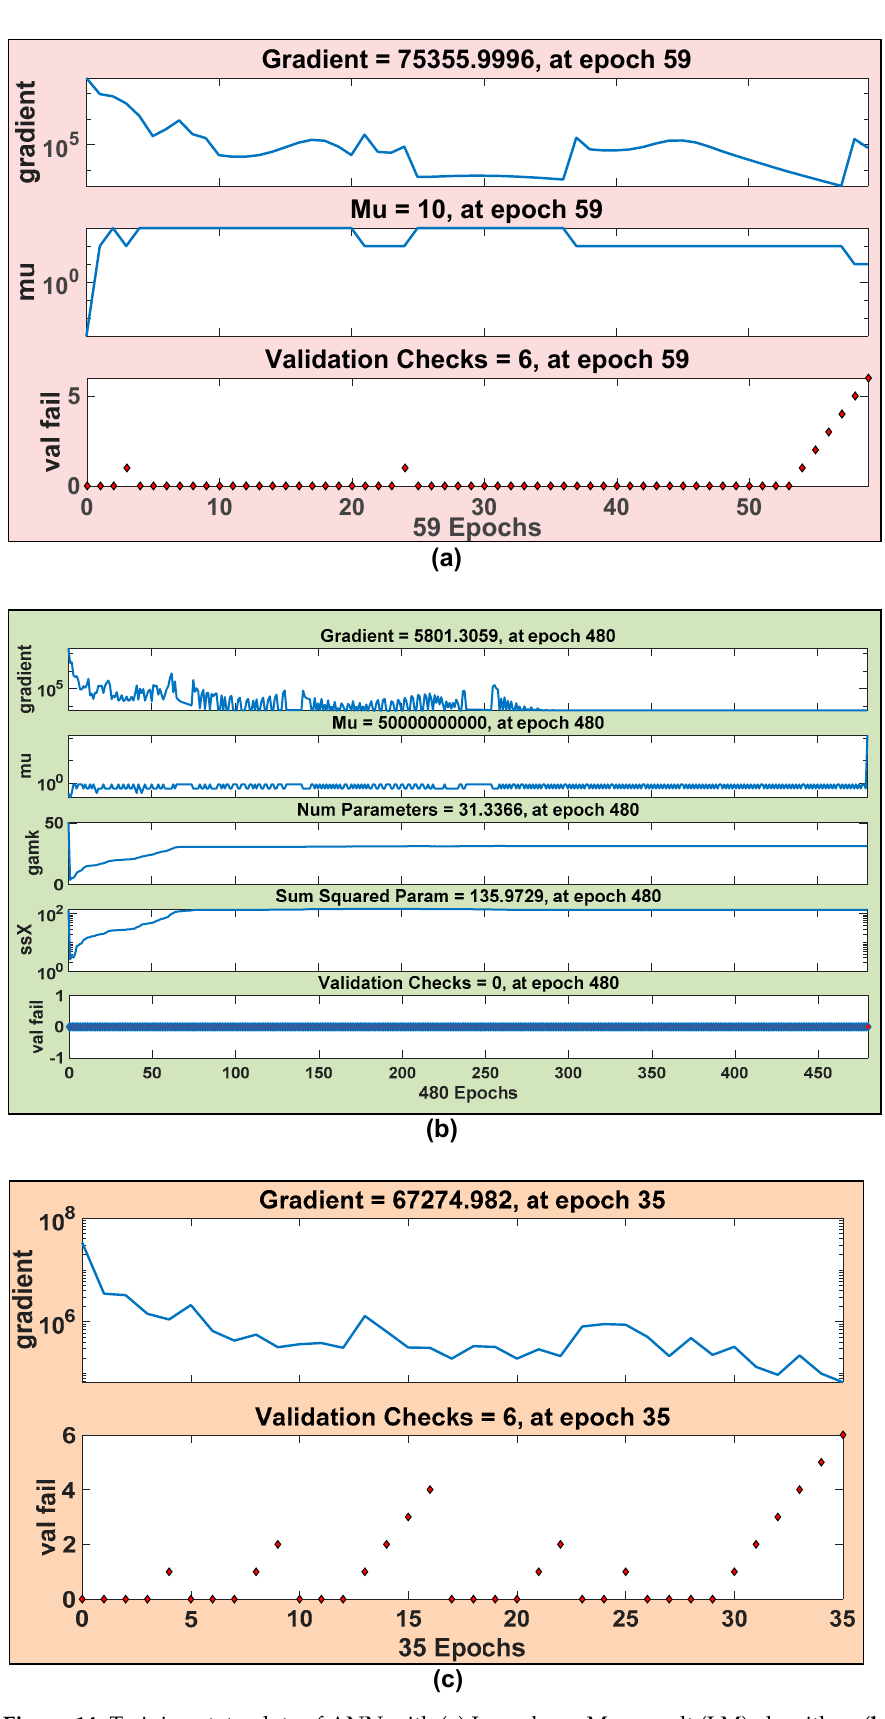
Figure 14. Training state plots of ANN with ( a ) Levenberg–Marquardt (LM) algorithm, ( b ) Bayesian Regulation (BR) algorithm, and ( c ) Scaled Conjugate Gradient (SCG) algorithm.